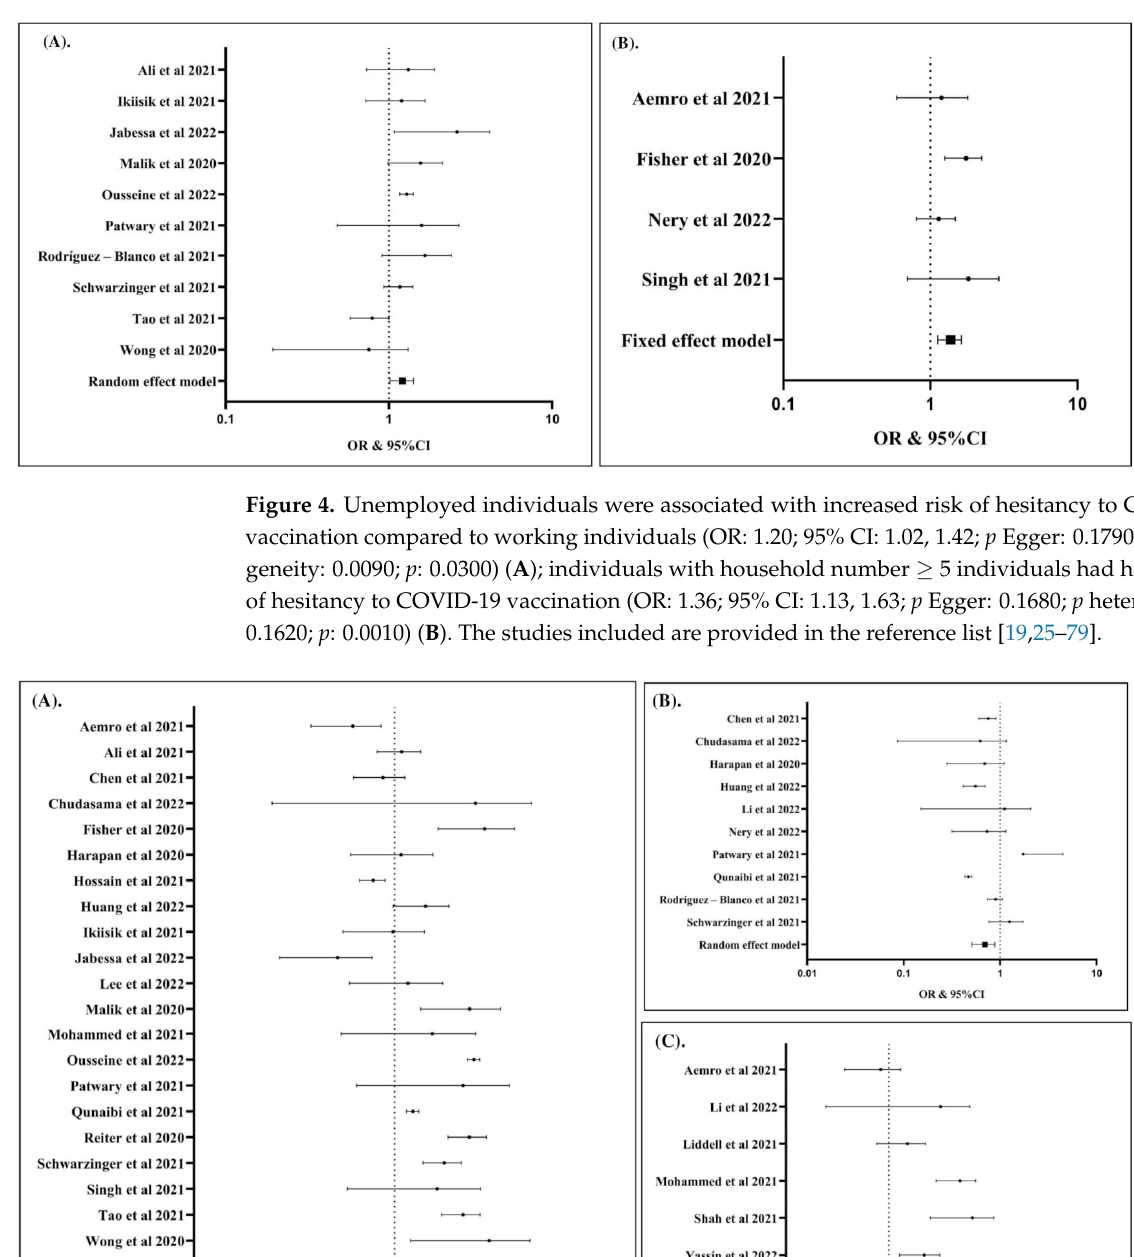
Figure 3. Female was associated with increased risk of hesitancy to COVID-19 vaccination compared to male (OR: 1.32; 95% CI: 1.17, 1.49; p Egger: 0.2840; p heterogeneity: <0.0001; p : <0.0001) ( A ). Indi- viduals with age > 50 years was associated with lower risk of hesitancy to COVID-19 vaccination compared to individuals with age ≤ 50 years (OR: 0.79; 95% CI: 0.64, 0.98; p Egger: 0.2980; p Het: <0.0001; p : 0.0290) ( B ). Single individuals had higher risk of hesitancy to COVID-19 vaccination than married individuals (OR: 1.19; 95% CI: 1.06, 1.34; p Egger: 0.1950; p heterogeneity: <0.0001; p : 0.0040) ( C ). The studies included are provided in the reference list [19,25–79].